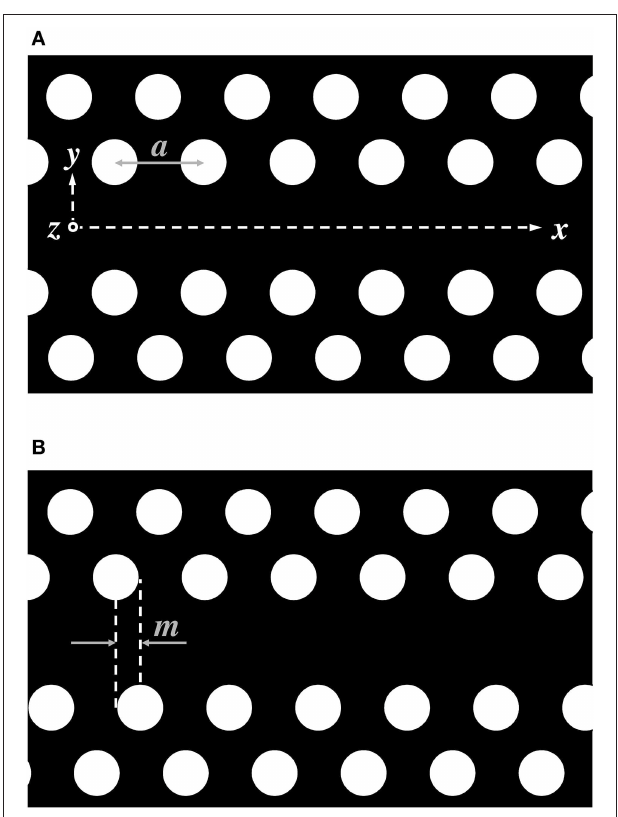
FIGURE 1 | PhC line-defect waveguides, where light propagates through the central part in the x -direction. The white circles are air-holes made on a black material (e.g., silicon), where the air-hole spacing (or lattice constant) is a , and the air-hole diameter is assumed to be smaller than a . (A) Air-hole alignments are symmetric with respect to the central line (or the x -axis). (B) The lower part of the air-hole alignment is shifted with the addition of a mismatch m , which causes the polarization rotation of light.